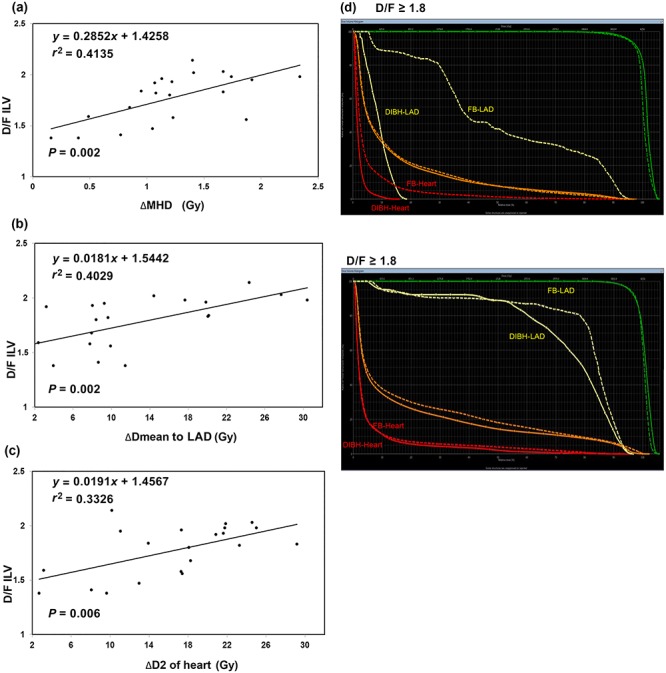
Relationship between the differences (Δ) in LAD and heart doses and the difference in ILV between FB and DIBH. The differences (Δ) in MHD (a), Dmean to LAD (b) and (c) and D2 of the heart (c) plotted against the difference in ILV between FB and DIBH. (d) The DVH comparison of IMRT treatment plans with and without DIBH gating. Left side: one patient with D/F (DIBH/FB) ILV = 1.83; right side: one patient with D/F ILV (ILV in DIBH/ILV in FB) = 1.59 (DIBH: solid line; FB: dashed line; heart: red; LAD: yellow; PTV: green; ipsilateral lung: orange). LAD = left anterior descending artery, ILV = ipsilateral lung volume, FB = free-breathing, DIBH = deep inspiration breath-hold, MHD = mean heart dose, Dmean = , D2 = near-maximum dose of 2 cc to the heart, DVH = dose–volume histogram, IMRT = intensity-modulated radiotherapy, PTV = planning target volume, DIBH-heart = DVH curve for heart based on DIBH plan.